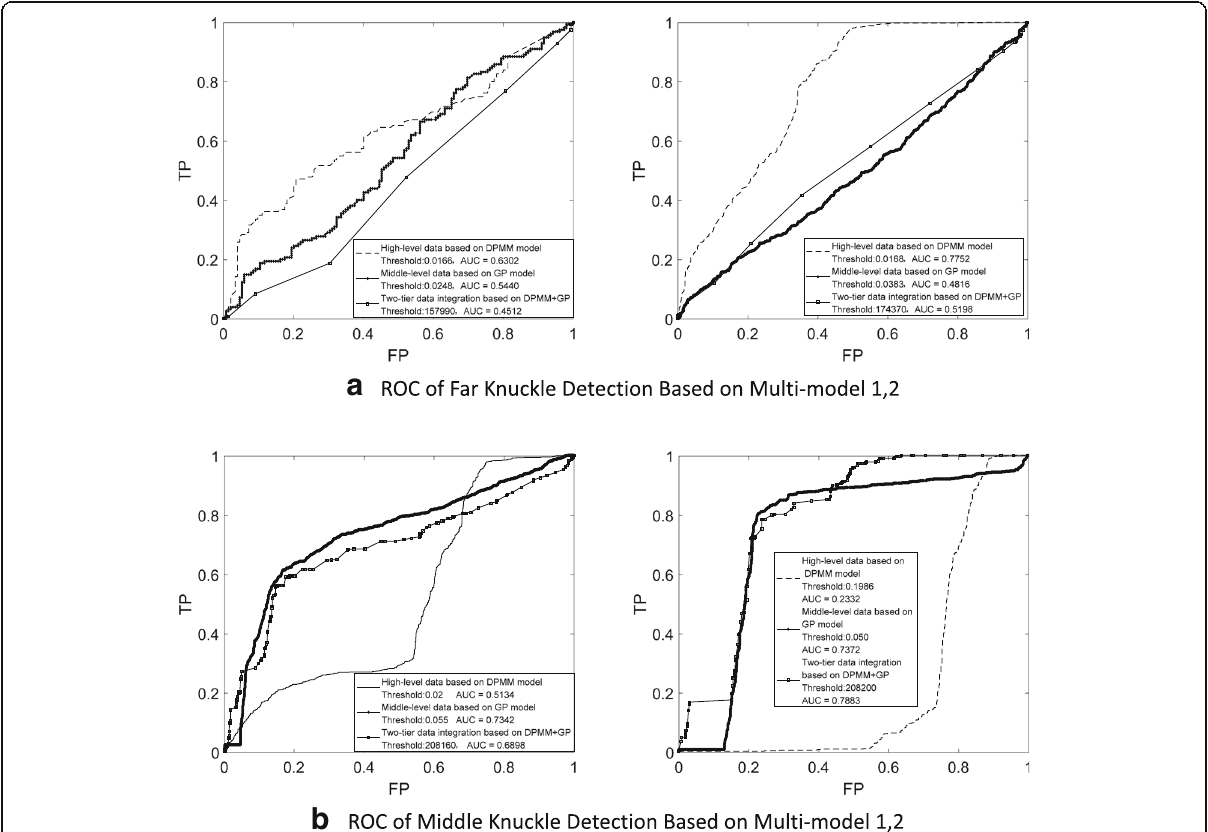
Fig. 9 Constant threshold image detection for knuckles based on different data models. a ROC of far-knuckle detection based on multi-model 1 and 2. b ROC of middle-knuckle detection based on multi-model 1 and